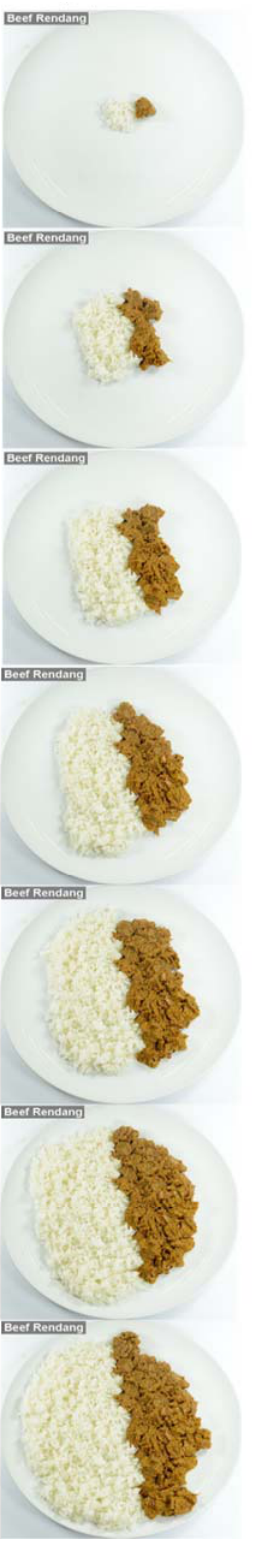
Figure 3. Example of the ‘multiple-choice’ version of the simplified portion size task (MPST).